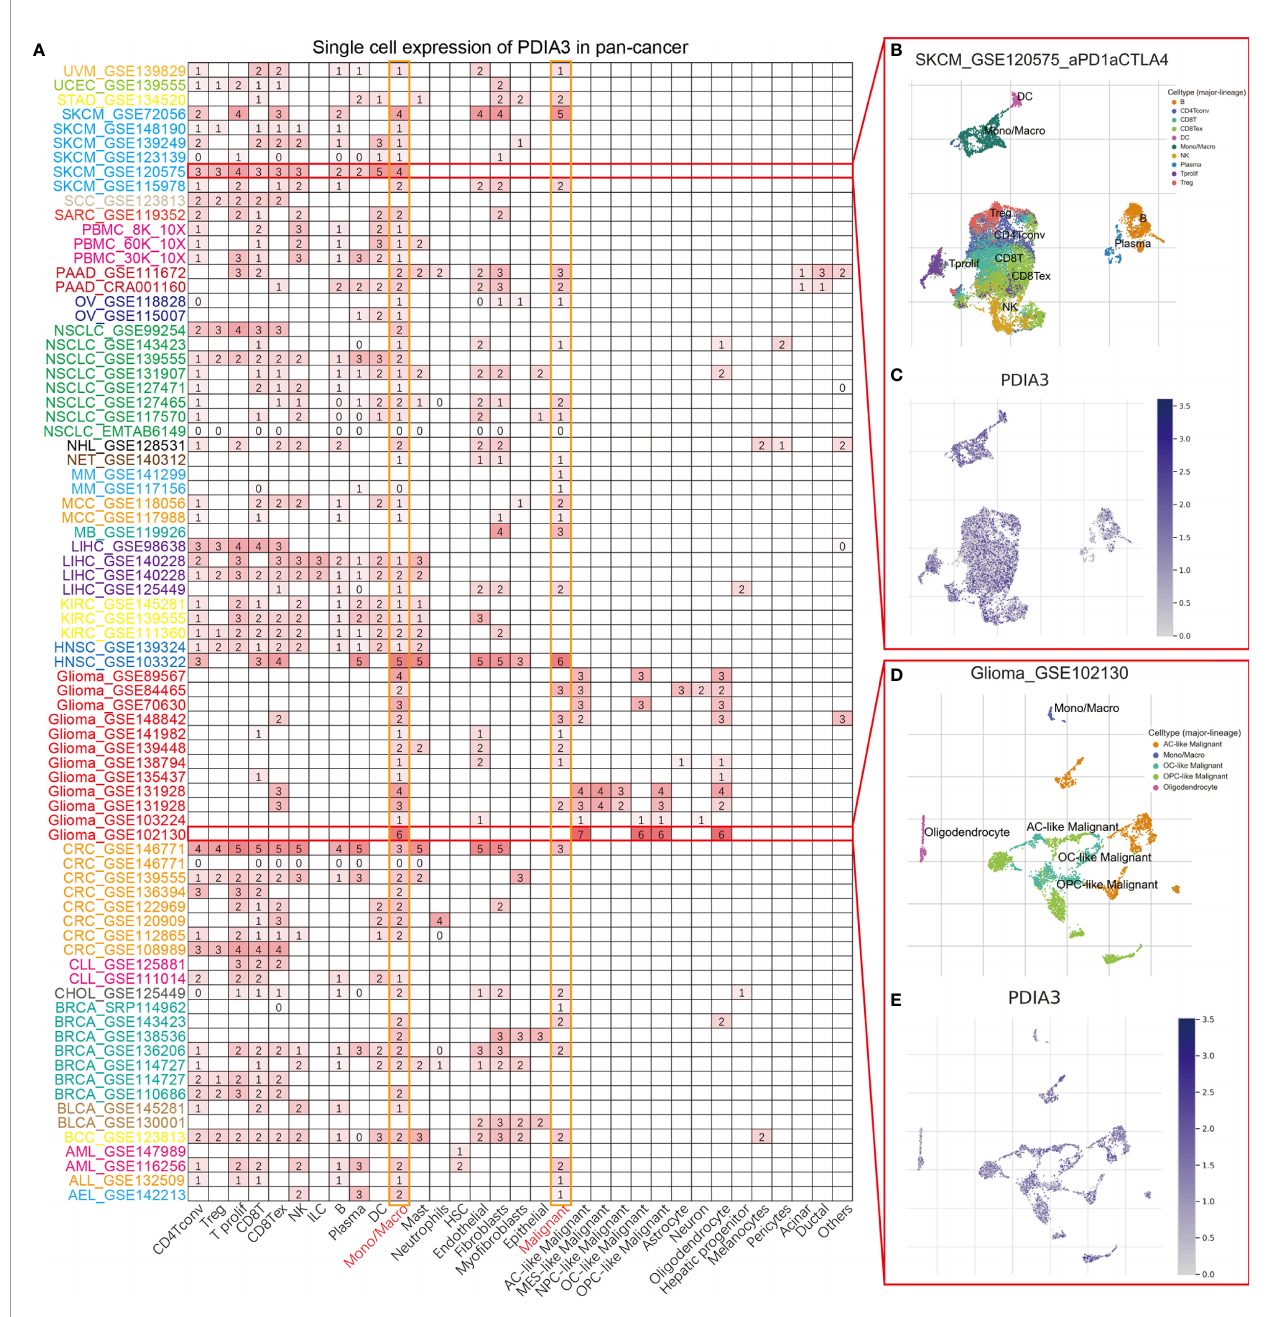
FIGURE 2 | (A) Summary of PDIA3 expression of 33 cell types in 79 single cell datasets. (B) Scatter plot showed the distributions of 10 different cell types of the GSE120575 SKCM dataset. (C) Scatter plot showed the PDIA3 expression levels of cells in the GSE120575 dataset. (D) Scatter plot showed the distributions of 5 different cell types of the GSE102130 glioma dataset. (E) Scatter plot showed the PDIA3 expression levels of cells in the GSE120575